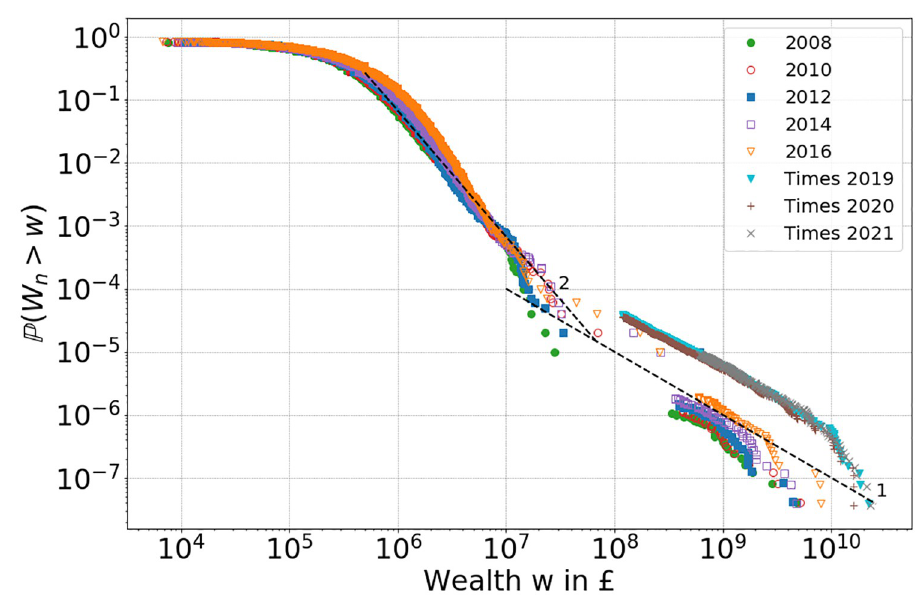
Fig 1. Empirical tail distribution of positive UK household wealth for five consecutive time periods 2008, 2010, 2012, 2014, 2016 from the WAS survey [18], together with Forbes rich list data on billionaires [19] (same colour code), and UK Times rich list data from 2019, 2020 (see Section SI.2.1 in S1 Appendix). Dashed lines indicate power-law tails with exponents 2 and 1 for